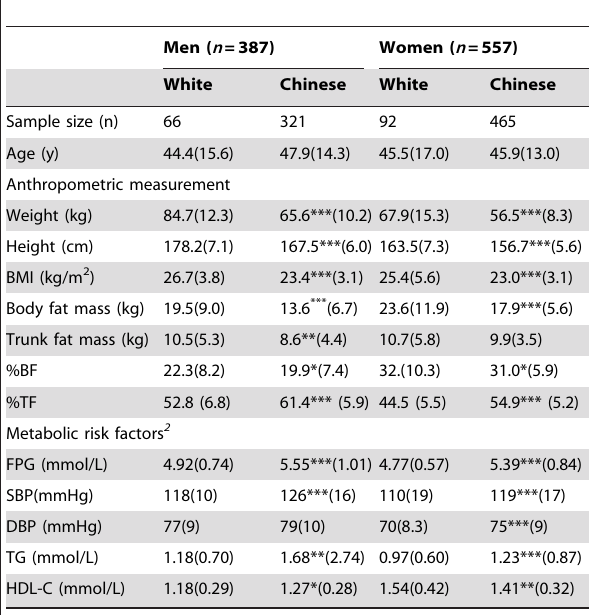
Table 1. Characteristics of the subjects by gender and ethnicity 1